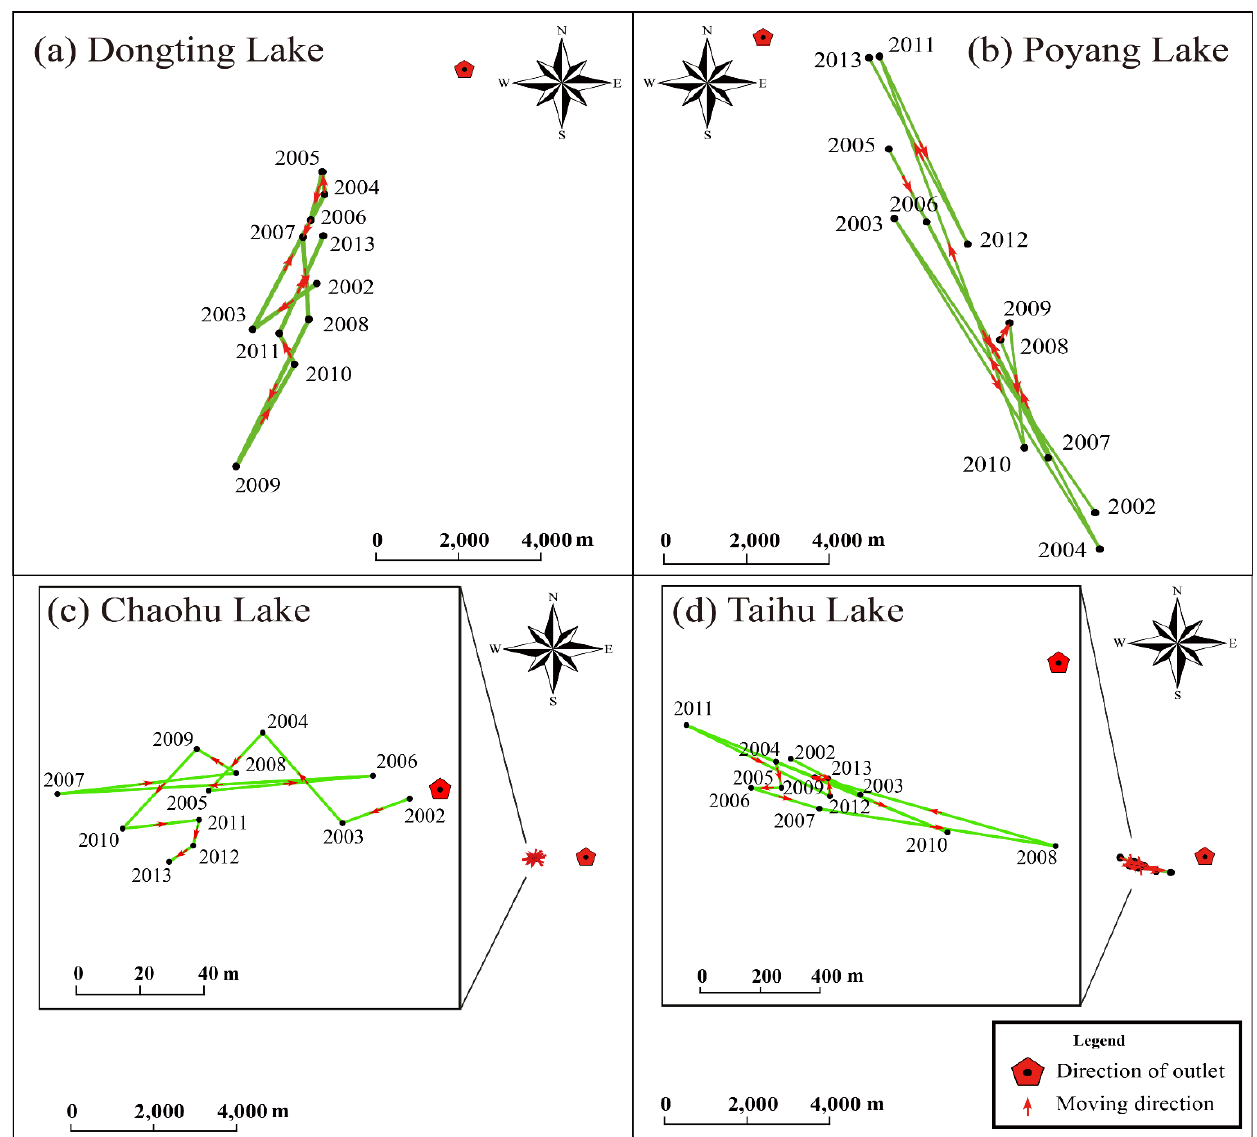
Figure 9. The movement of the centroids of the four lakes, ( a ) Dongting Lake; ( b ) Poyang Lake; ( c ) Chaohu Lake; ( d ) Taihu